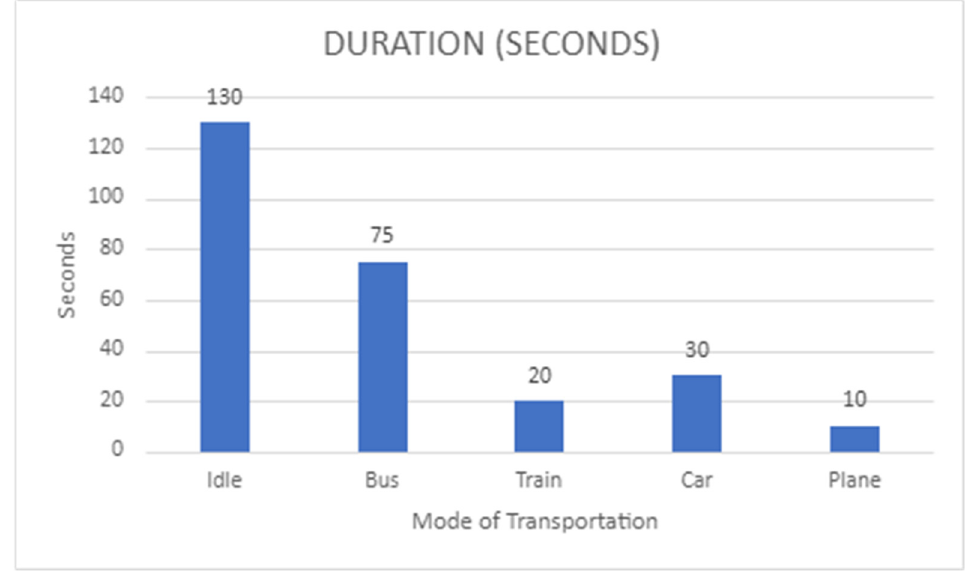
Figure 13. Transportation detection while in a bus and exiting at a bus stop (total of 10 min total).